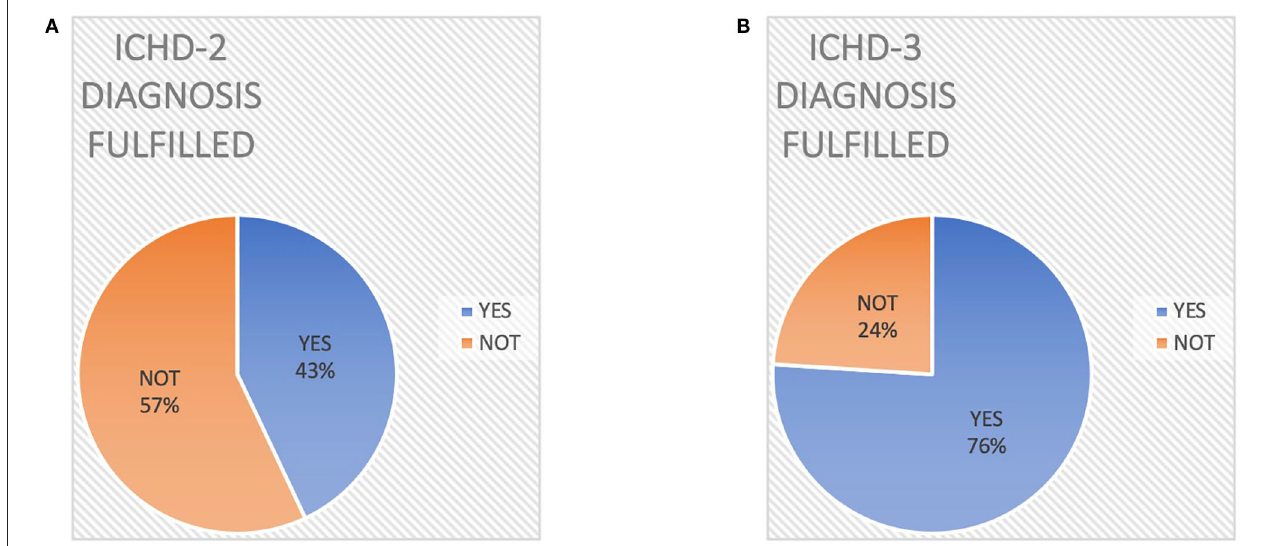
FIGURE 2 | Different diagnostic rate of Medication Overuse Headache according to ICHD-2 criteria (A) vs. ICHD-3 criteria (B)